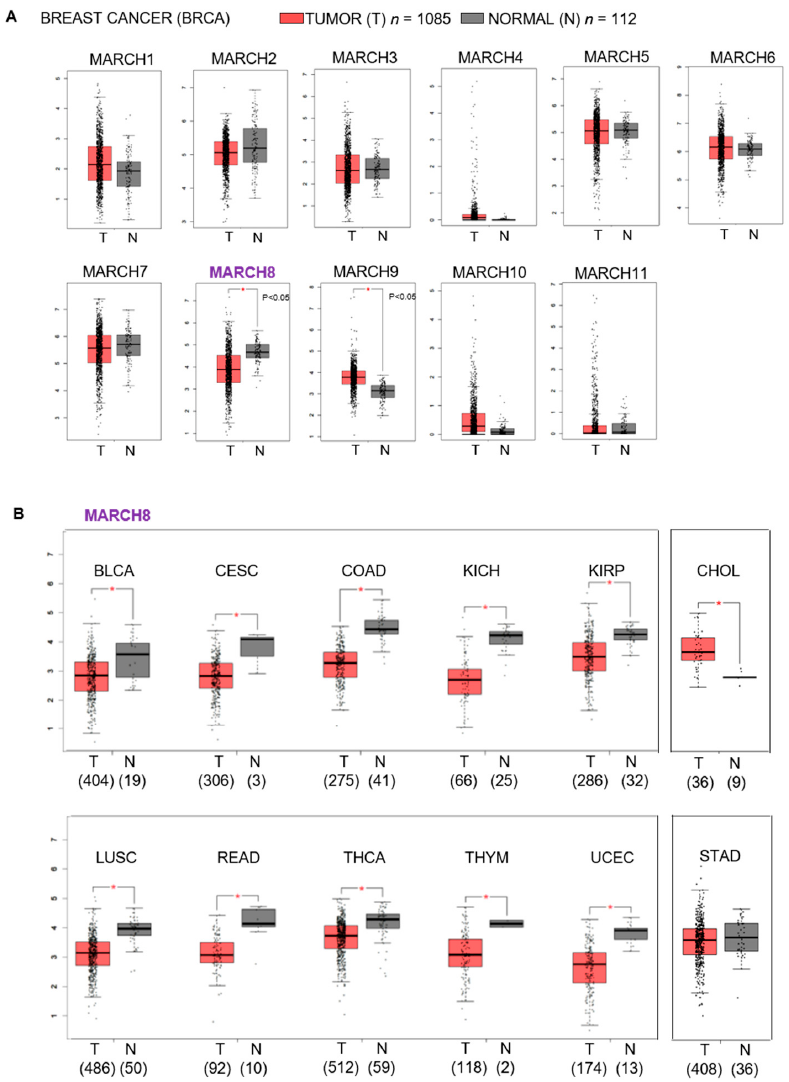
Figure 1. MARCH family gene expression levels in human tumors and normal tissues in TCGA.